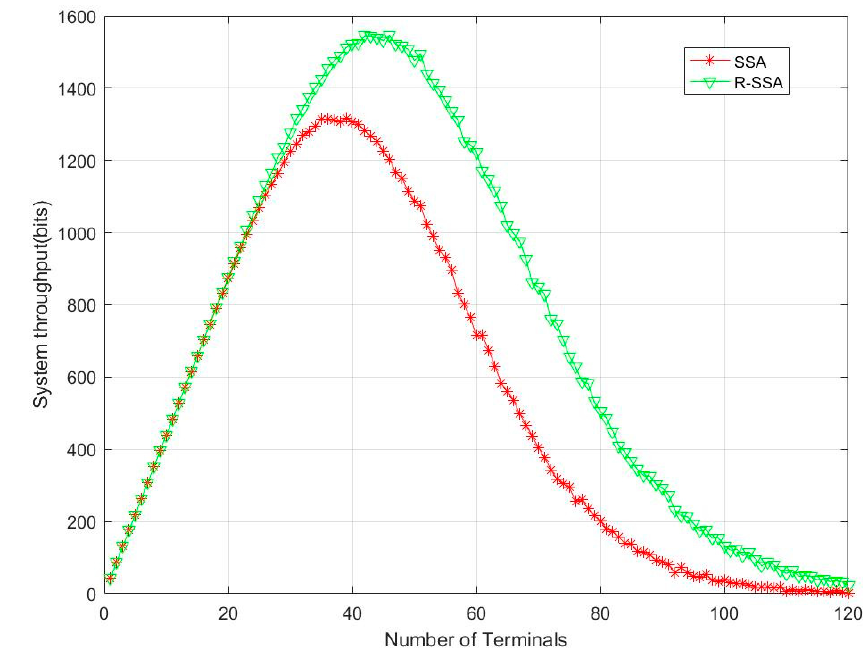
Figure 16. R-SSA vs. SSA in the throughput.